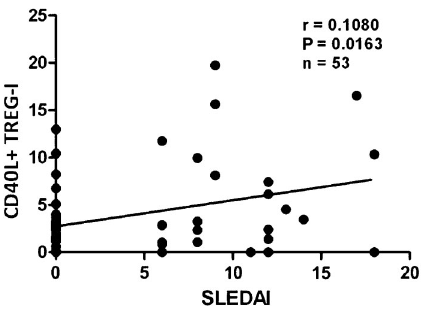
Figure 4. Correlation between the relative frequency of CD40L + TREG-I cells and disease activity (SLEDAI) in patients with SLE. The relative frequency of CD40L + TREG-I cells was calculated over total TREG-I (CD25 + CD127 Ø/low FoxP3 + ). The Spearman correlation test was used for analysis.